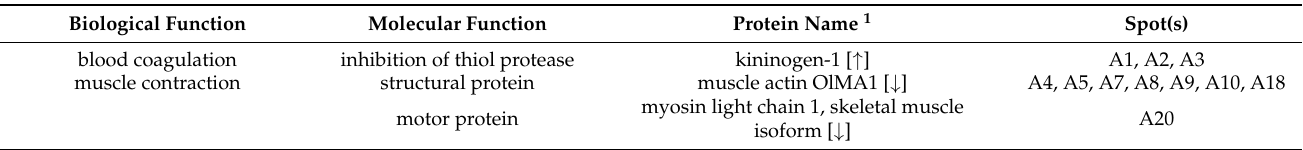
Table 3. Major functions of identified differentially expressed medaka proteins with at least two-fold changes at any time point upon exposure to K. mikimotoi